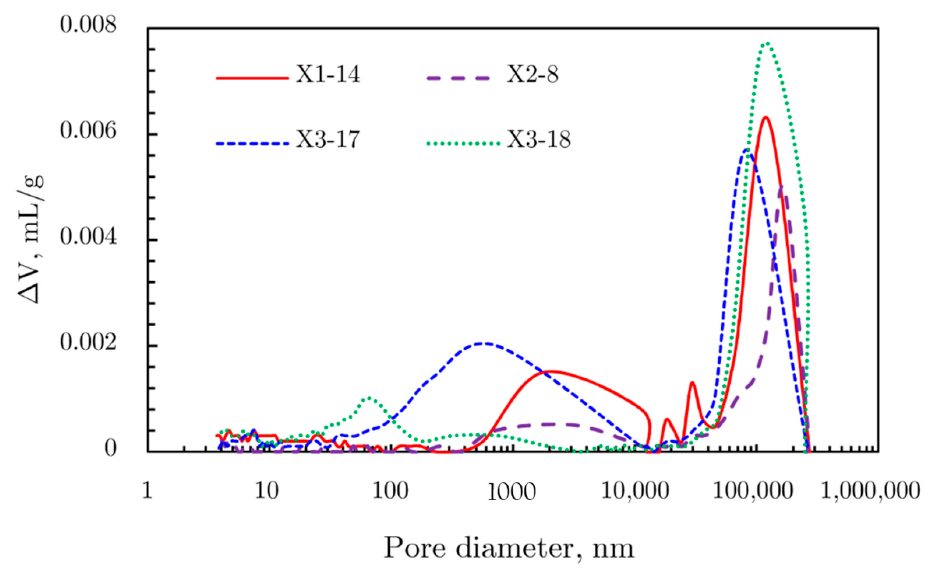
Figure 11. PSD of samples from the Longmaxi Formation based on mercury intrusion.